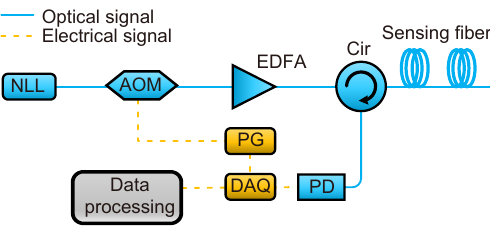
Fig. 1 | The setup of DVS-Φ-OTDR system based on direct de-